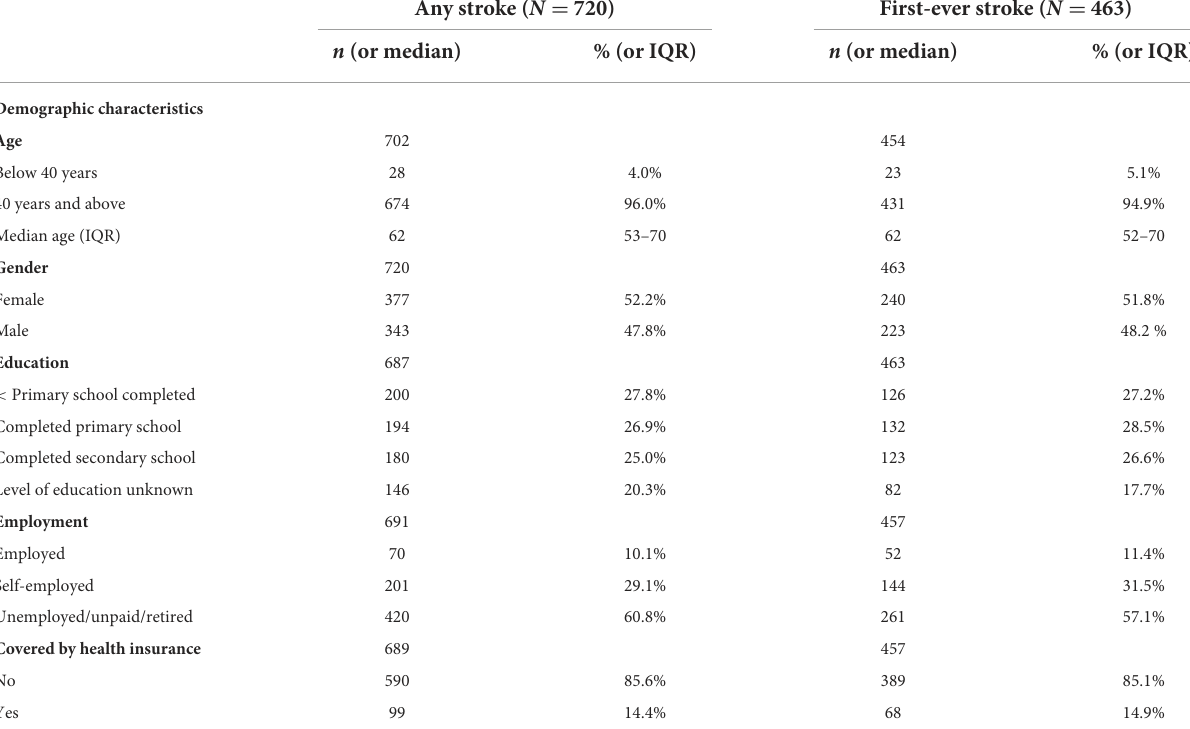
TABLE 2 Socio-demographic characteristics of study